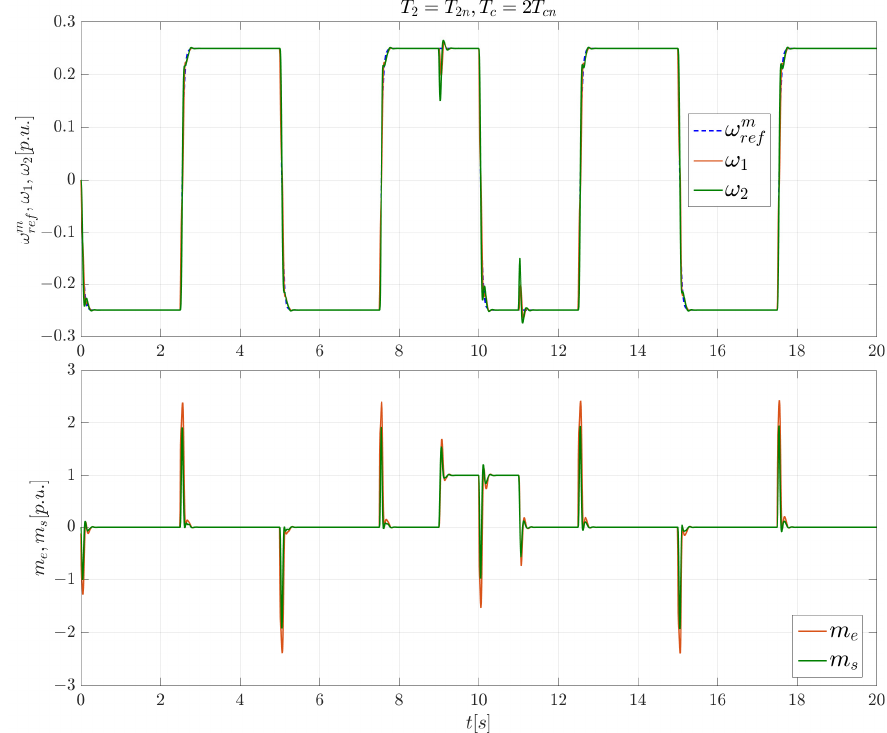
Figure 9. Speeds ( ω ref , ω 1 , and ω 2 ) and torques ( m e and m s )—transients for the increased stiffness time constant ( T c = 2 T cn ).